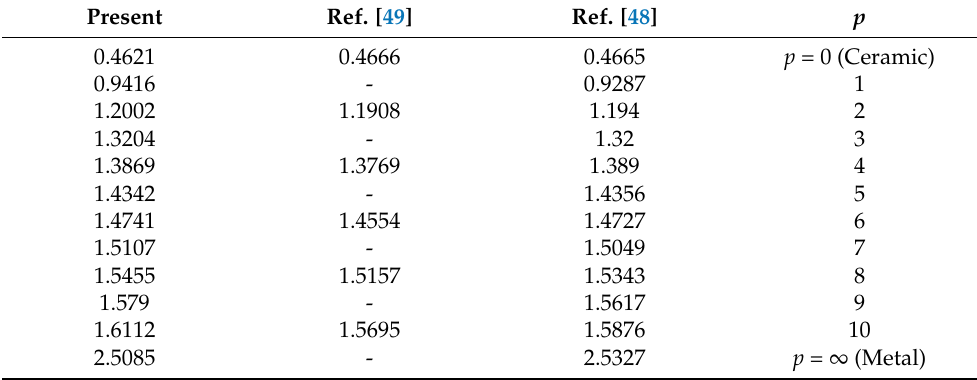
Table 4. Effect of the volume fraction exponent of the FG material on the dimensionless deflections of SSSS FG square plates.